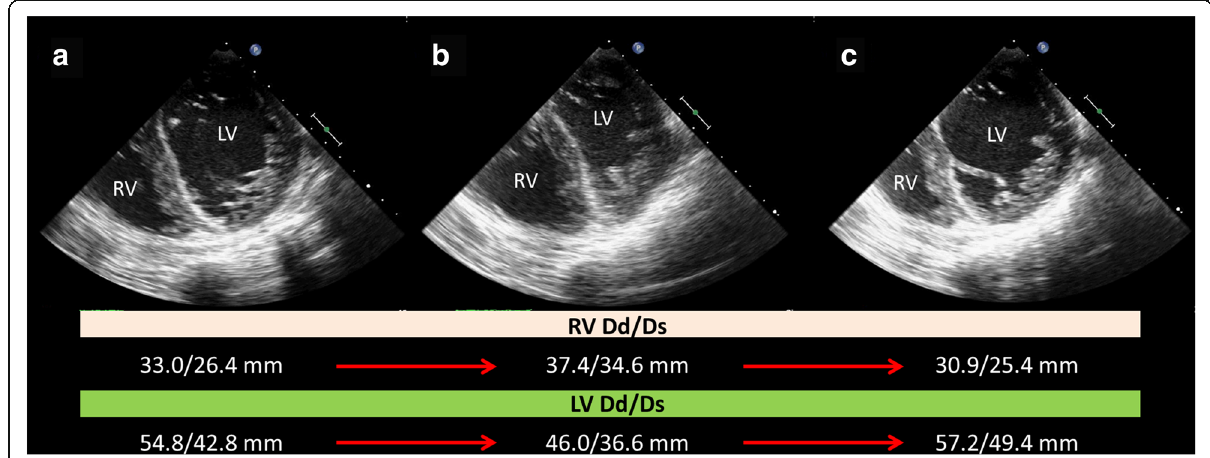
Fig. 2 Mid-esophageal four-chamber TEE images collected during the procedure. a TEE image after THV deployment showing normal RV size (RV Dd/Ds = 33.0/26.4 mm). b TEE image collected 2 min after protamine administration demonstrating RV dilatation ( yellow arrow ) (RV Dd/Ds = 37.4/ 34.6 mm) and left ventricular (LV Dd/Ds = 46.0/36.6 mm) volume reduction. Severe systemic hypotension was observed at the same time. c TEE image after 1 min of chest compressions (approximately 5 min after protamine administration) demonstrating that the RV and LV size and wall motion had returned to baseline (RV Dd/Ds = 30.9/25.4 mm, LV Dd/Ds = 57.2/49.4 mm). Dd dimension end-diastole, Ds dimension end-systole, LV left ventricle, RV right ventricle, TEE transesophageal